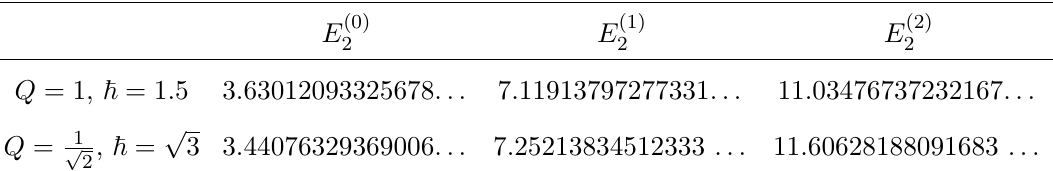
Table 1. Numerical eigenvalues E ( n )